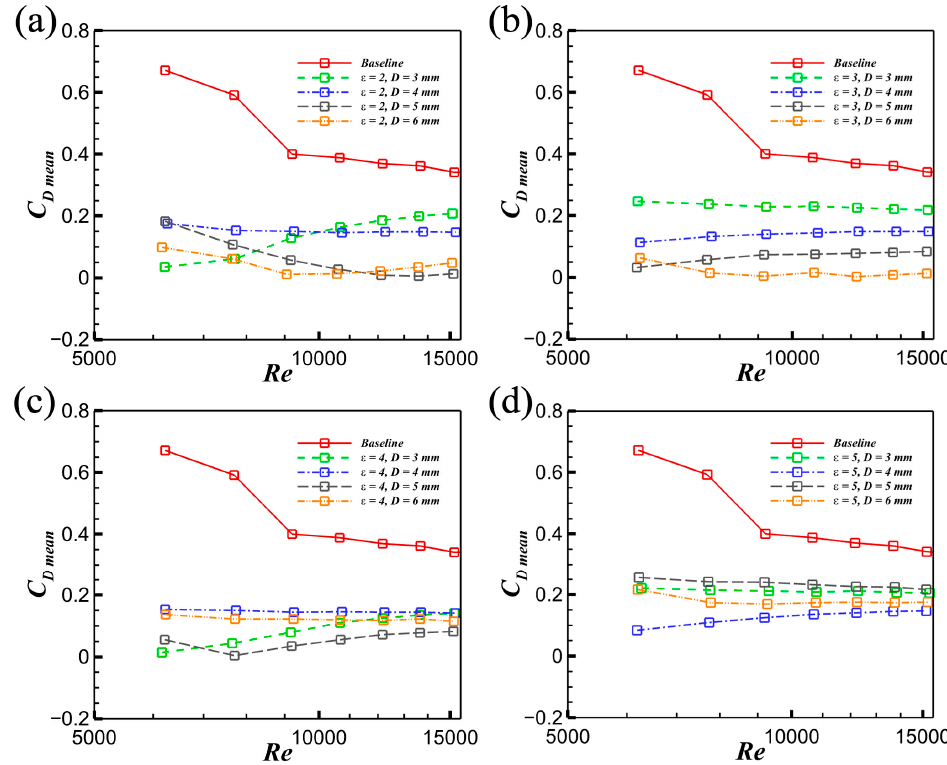
Figure 15. ( a – d ) The relationship between the time-averaged drag force coefficient and the Reynolds number at different spacing ratios and cylinder diameters.